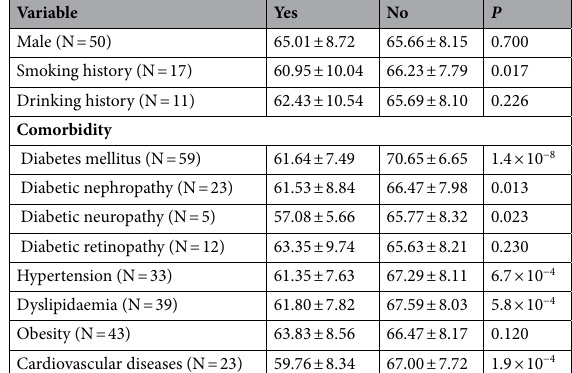
Table 2. Membrane fluctuations of red blood cells associated with clinical status in all participants. Values are expressed as the mean ± SD of membrane fluctuation (nm). Smoking history refers to current or ex-smokers. Drinking history refers to current or